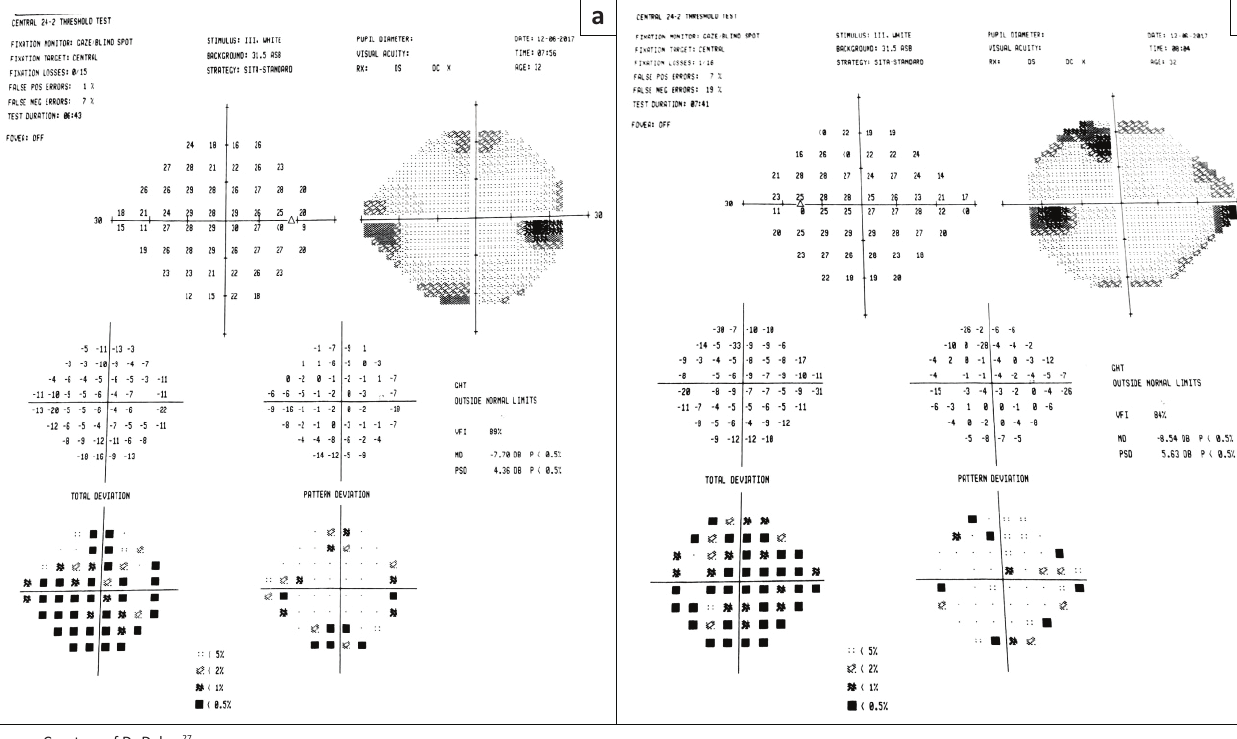
FIGURE 4: Showing progressive peripheral visual field loss of the (a) right eye and (b) left eye in 2017 (compare with baseline visual field in Figures 2a and